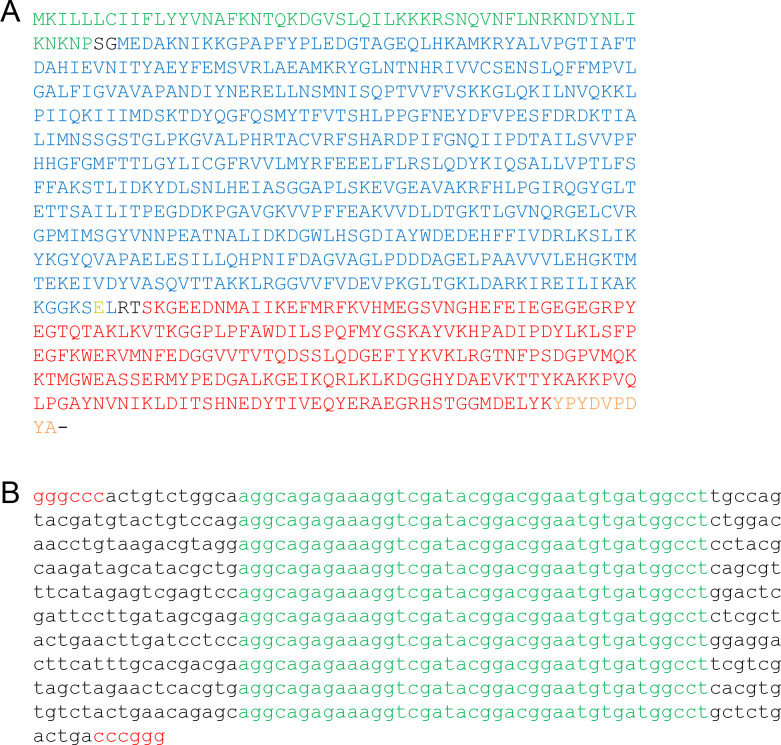
Sequences found in plasmid p15-p230-aFluc-mCh.(A) The firefly luciferase protein (blue) is shown with an apicoplast-targeting peptide (green), mCherry fusion protein (red) and HA tag (orange). The K549E mutation to limit peroxisomal trafficking is colored yellow. (B) The sequence of the modified 10 aptamer sequence is shown flanked by endonuclease sites (red). The 23 bp aptamer regions (green) are separated by spacers with unique sequences (black).